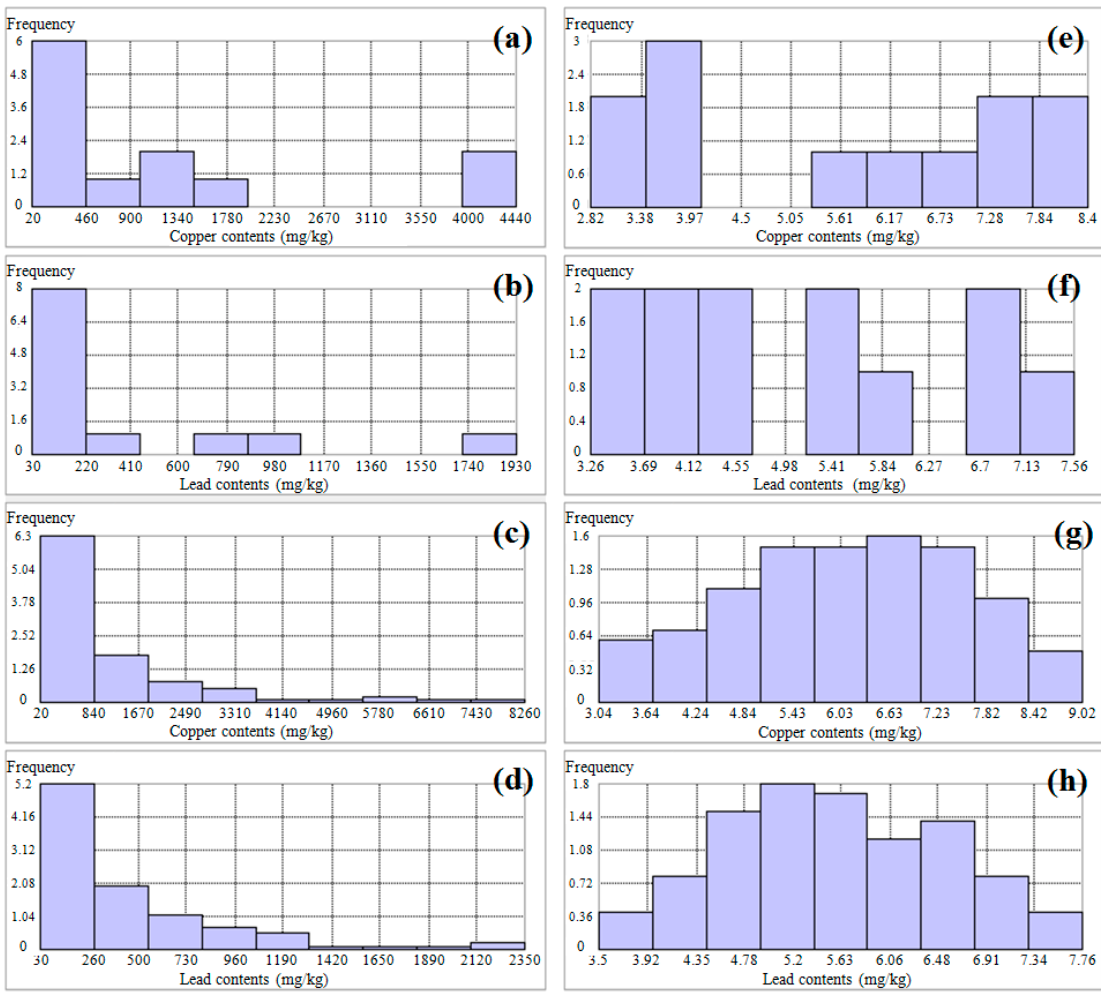
Figure 3. Histograms of copper and lead contents analyzed by the ICP–AES and PXRF instruments: ( a , b ) copper and lead by ICP–AES, respectively; ( c , d ) copper and lead by PXRF, respectively; ( e , f ) natural logarithms of copper and lead by ICP–AES, respectively; and ( g , h ) natural logarithms of copper and lead by PXRF, respectively.